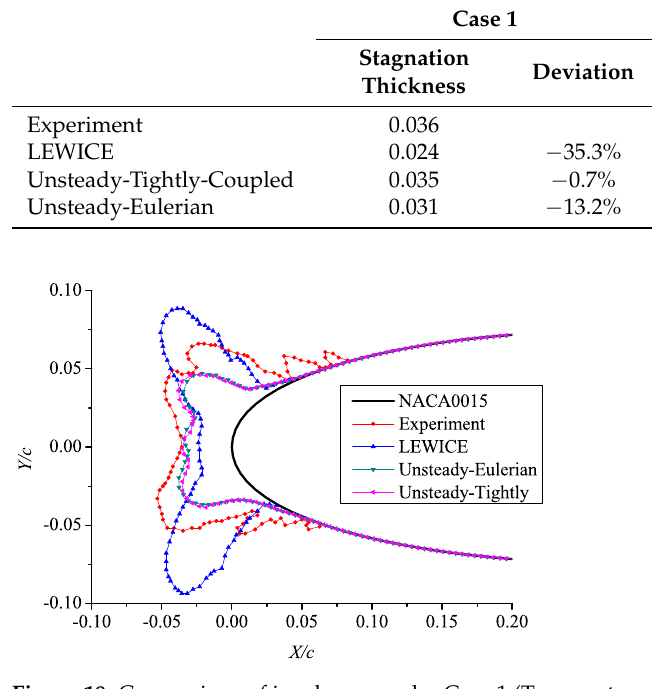
Figure 18. Comparison of ice shapes under Case 1 (Temperature = − 9.9 ◦